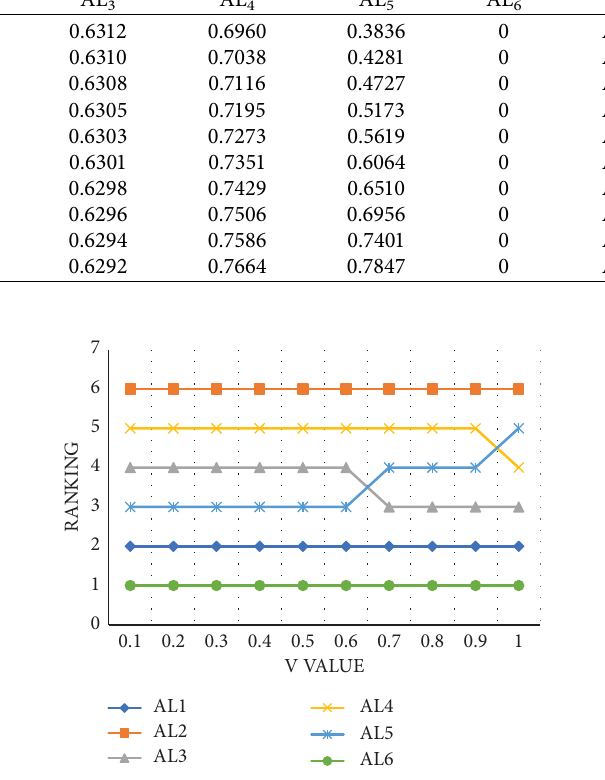
Figure 6: Results of sensitivity